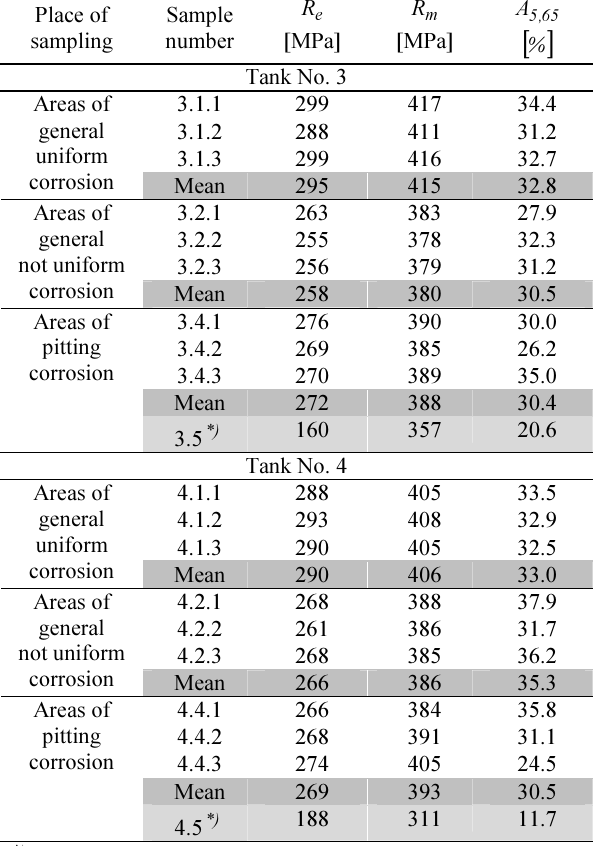
Table 2. Results of static tensile strength test of material from tank No. 22 Place of sampling